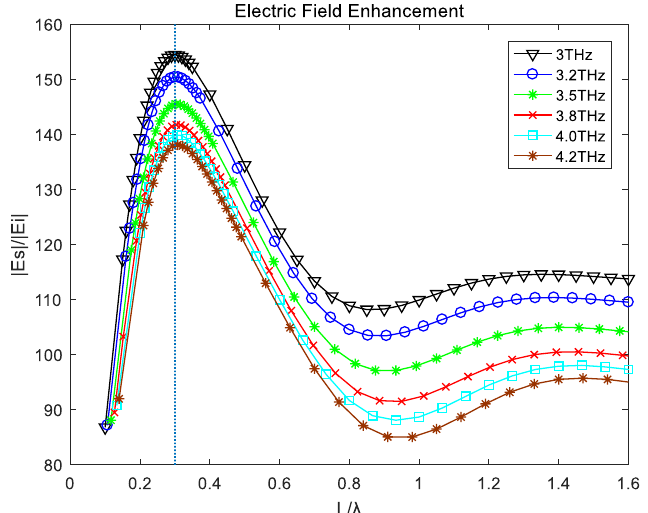
Figure 11. Simulation results of electric field enhancement of matching the tip length to the wavelength.